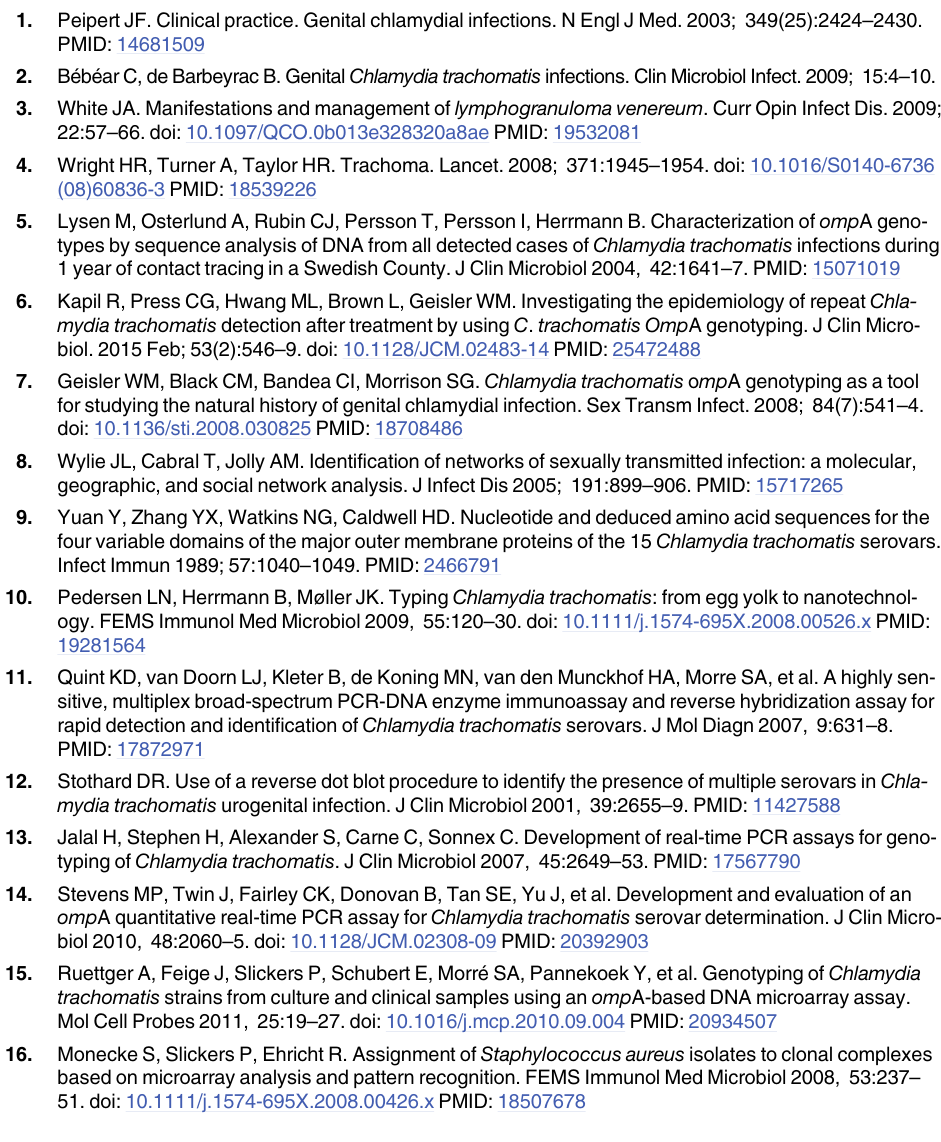
S1 Table. C . trachomatis omp A sequencing results.